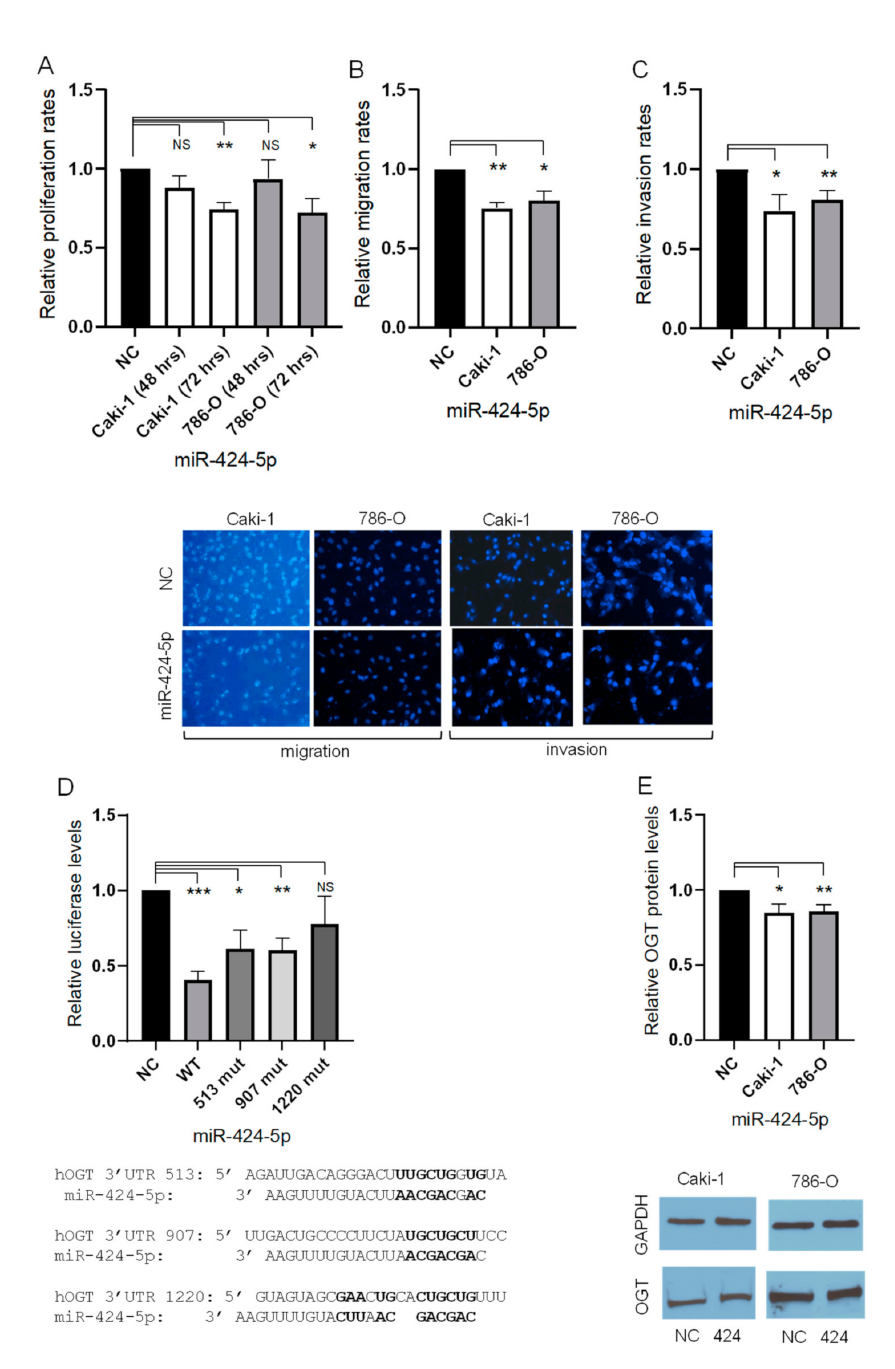
Figure 1. The effect of miR-424-5p on the ccRCC phenotype and expression of OGT. ( A ) The proliferation rates of cell lines transfected with pre-miR-424-5p after 48 h and 72 h, relative to negative control transfectants. ( B ) The migration rates of cell lines transfected with pre-miR-424-5p after 20 h, relative to negative control transfectants (representative images below, 20 × magnification). ( C ) The invasion rates of cell lines transfected with pre-miR-424-5p after 30 h, relative to negative control transfectants (representative images below, 20 × magnification). ( D ) The luciferase activity based on the WT 3 (cid:48) UTR as well as three mutated sites of the 786-O cell line transfected with pre- miR-424-5p, relative to negative control transfectant (predicted sites detailed below). ( E ) The OGT protein expression of cell lines transfected with pre-miR-424-5p after 48 h, relative to negative control transfectants (representative images below) (Figures S3–S6). * p < 0.05, ** p < 0.01, *** p < 0.001, and NS = not